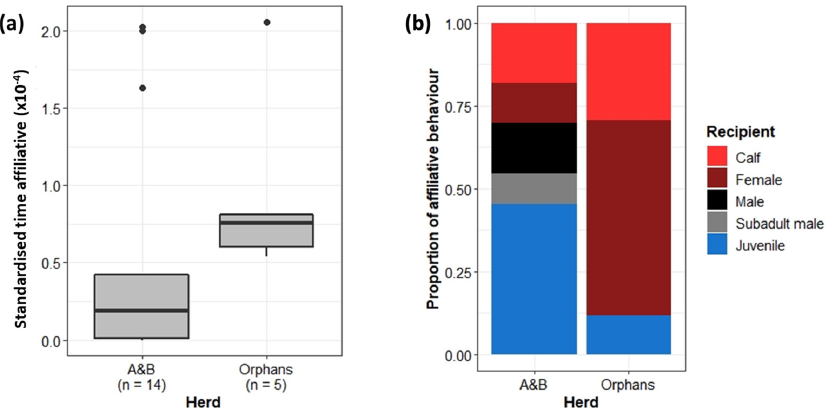
Figure 6. ( a ) Proportion of time spent exhibiting affiliative behaviours in the A&B herd and Or- phans. Boxplots show median, IQR, and outliers. Numbers on the x-axis indicate the number of individuals included in the analysis for each herd. ( b ) The proportion of affiliative behaviour di- rected towards other demographic groups. “Male” refers to independent adult bulls. “Subadult male” refers to semi-independent sub-adult bulls.